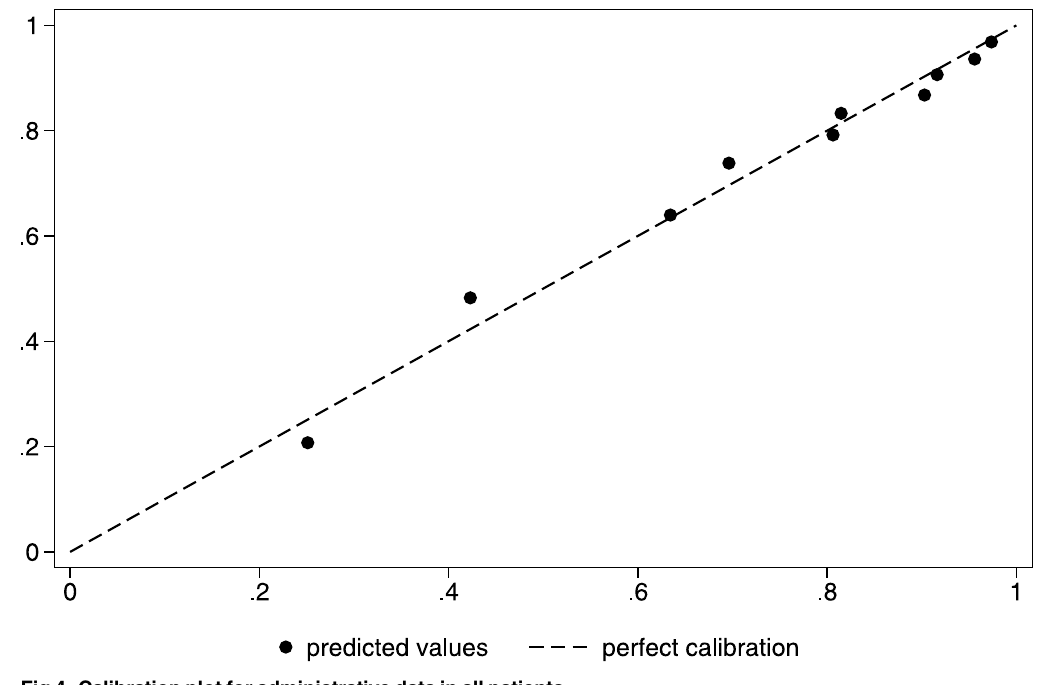
Fig 4. Calibration plot for administrative data in all